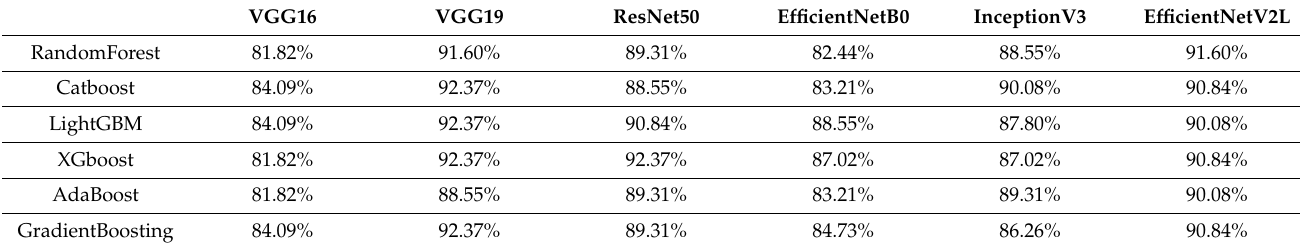
Table A4. Accuracy of each model combination for gray ovals.